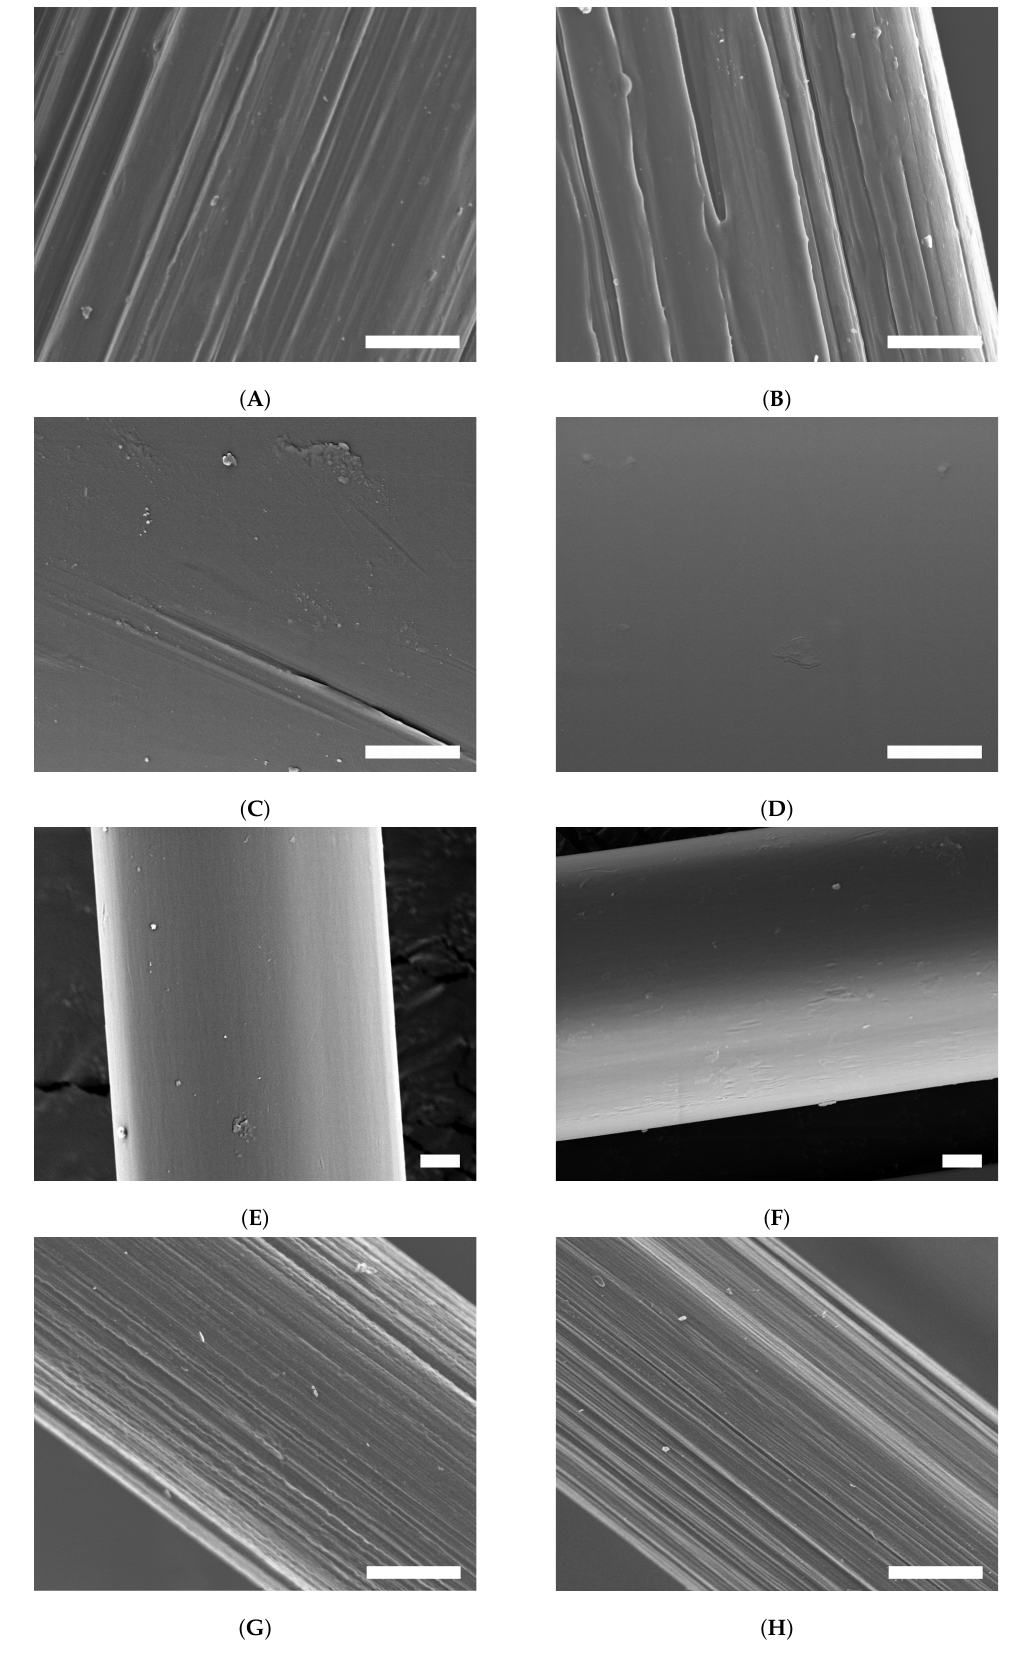
Figure 3. SEM images of treated and untreated fibers; bar =2 µ m. ( A ) untreated UHMW PE; ( B ) treated UHMW PE; ( C ) untreated PPS; ( D ) treated PPS; ( E ) untreated PPTA; ( F ) treated PPTA ; ( G ) untreated CF; ( H ) treated